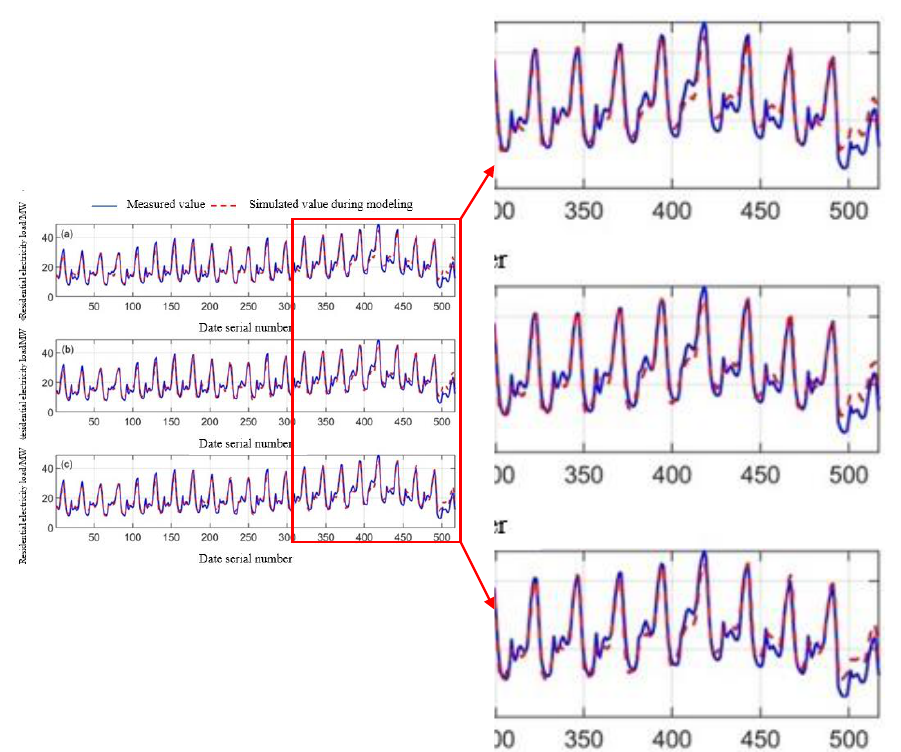
Figure 9. Optimized support vector machine model to predict the hourly load of residents in winter: